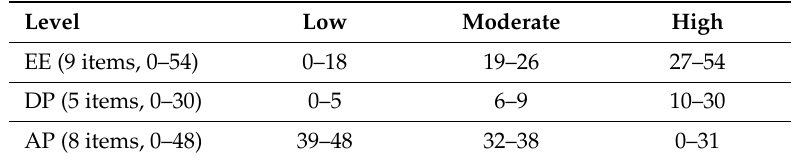
Table 1. Classification of burnout